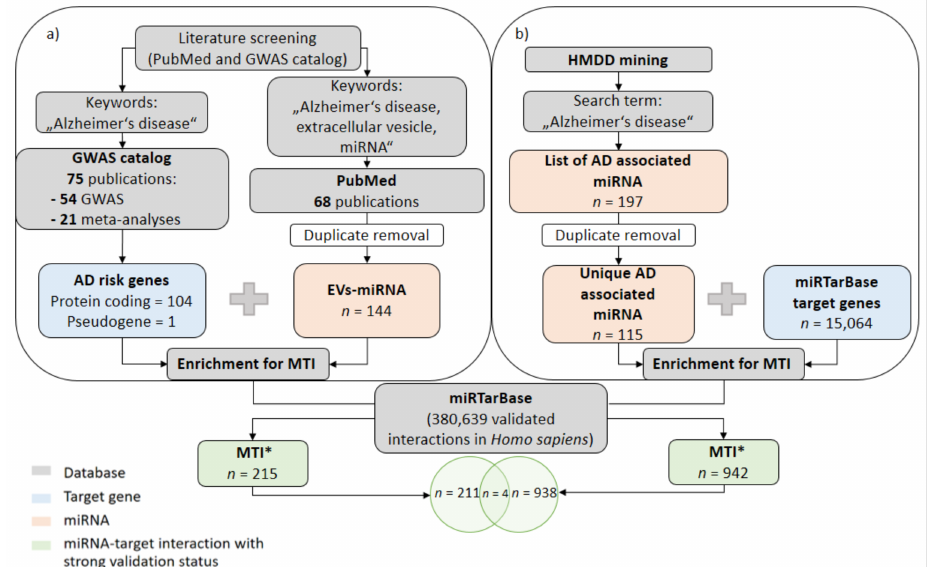
Figure 1. Integration of literature screening and database mining for AD-related miRNAs and target gene evaluation and prioritization of MTI: ( a ) Previously published work on AD risk genes was combined with a list of miRNAs associated with extracellular vesicles obtained from literature search. miRNA-target interactions on various phenotypes and diseases were extracted from miR- TarBase. ( b ) Apart from that, HMDD mining resulted in list of AD-associated miRNAs that were combined with the complete list of genes in miRTarBase for evaluation of miRNA-target interac- tions. AD = Alzheimer‘s disease; EVs = extracellular vesicles; HMDD = Human microRNA Disease Database; MTI = miRNA-target